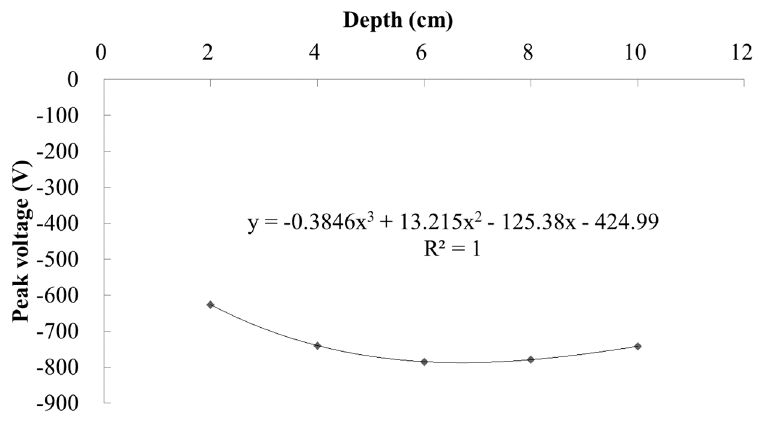
Figure 9. Curves of maximum negative voltages with buried depth when load passes directly above the PEH.